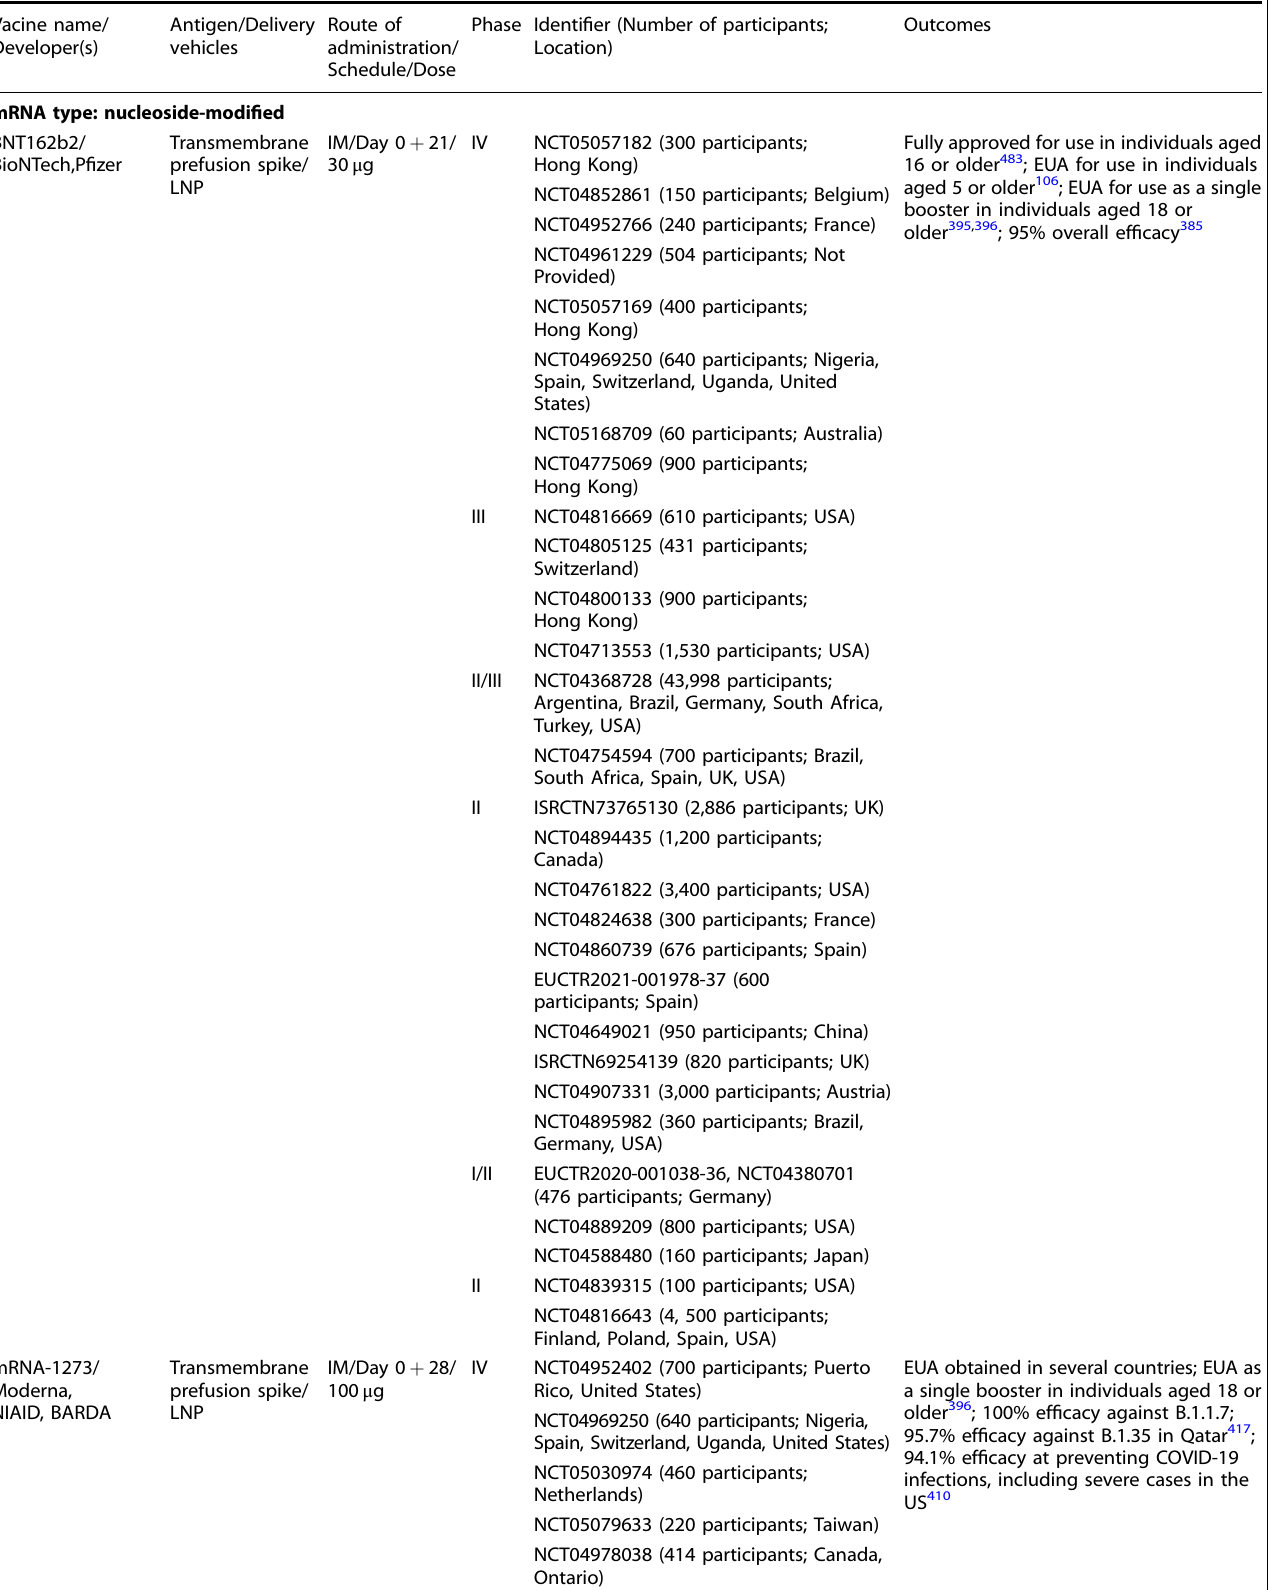
Table 5. mRNA vaccine candidates for COVID-19 currently in clinical